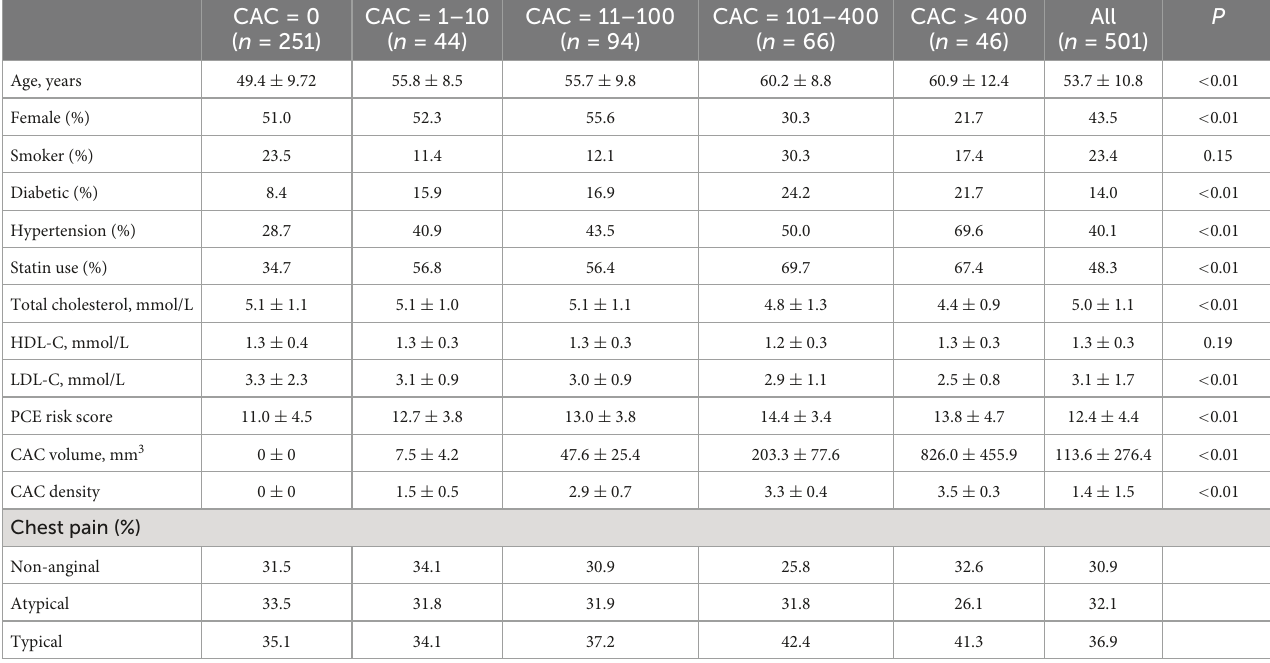
TABLE 1 Clinical characteristics of patients stratified across coronary artery calcium (CAC) Agatston score categories.